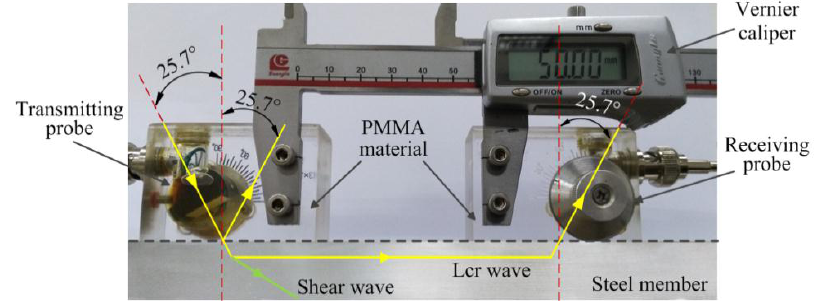
Figure 3. Lcr wave testing device.